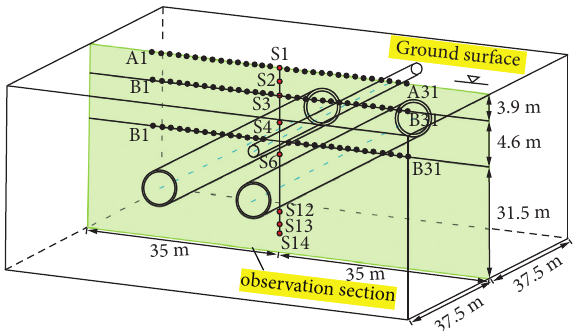
Figure 14: Observation section in numerical simulation.